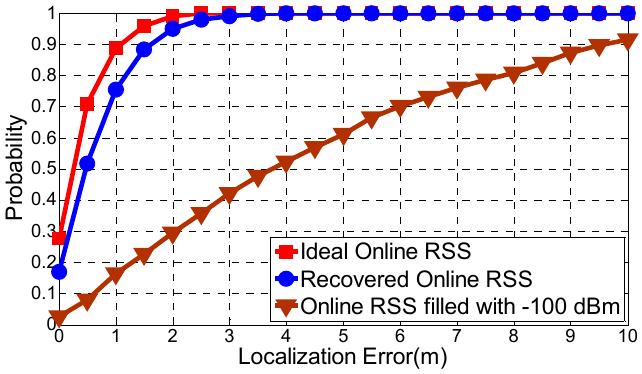
Figure 17. Localization performance for online RSS vectors recovery based on SVT